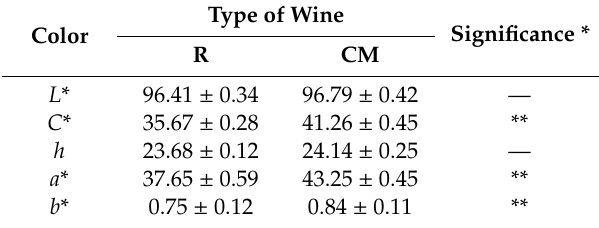
Table 2. Colors of Muscat Hamburg wines from di ff erent winemaking technologies. Type of Color